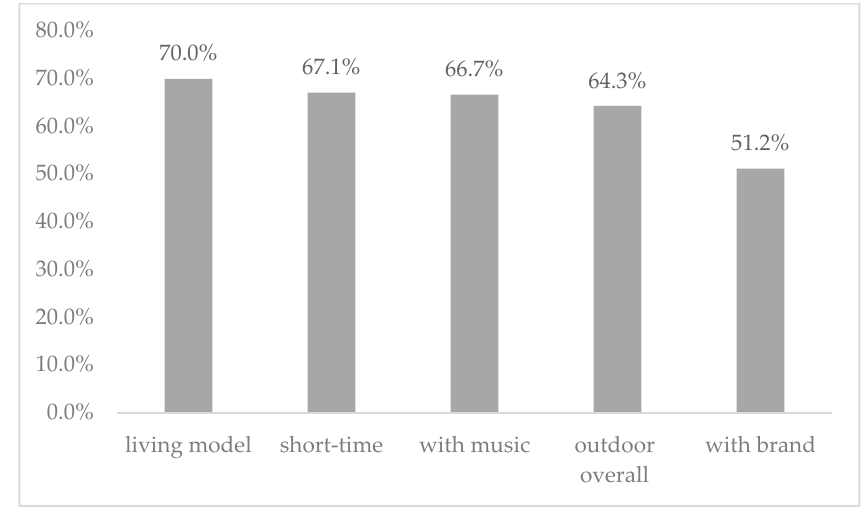
Figure 2. The ratios of preferences for the characteristics of short video clothes displays.